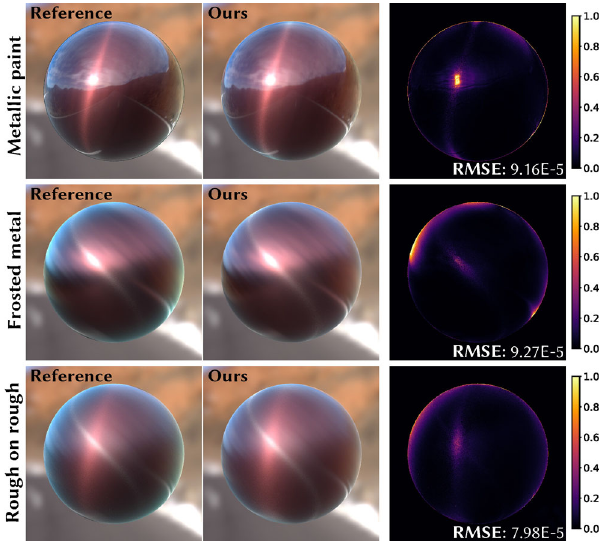
Fig. 6 Our results are visually compared with the reference images, and the error value for each pixel is also visualized in the images to the right. The root-mean-square error (RMSE) values are shown to the bottom left. The roughness parameters for these results are the same as those used for Figs. 4(a), 4(b), and